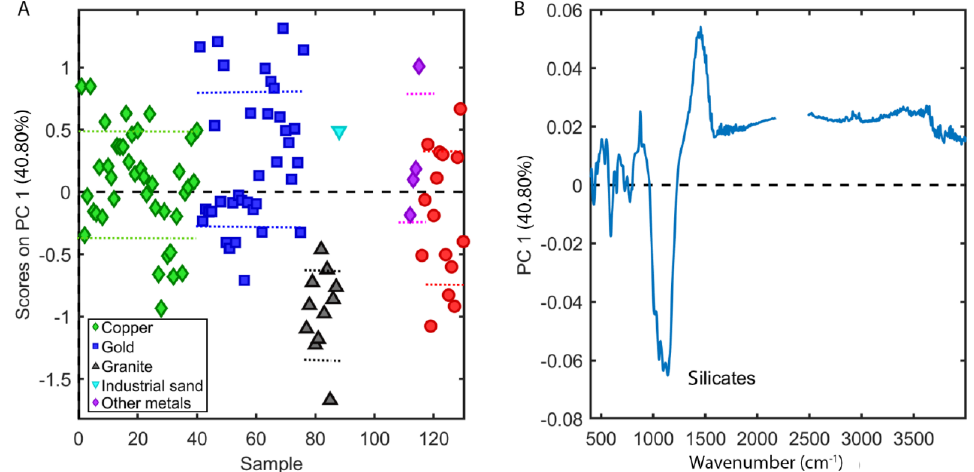
Figure 7. PCA scores and loadings for FTIR spectra with limestone and iron samples removed from the dataset ( A ) Sample Scheme 1. v. samples; ( B ) Loadings for PC1 v. variable.